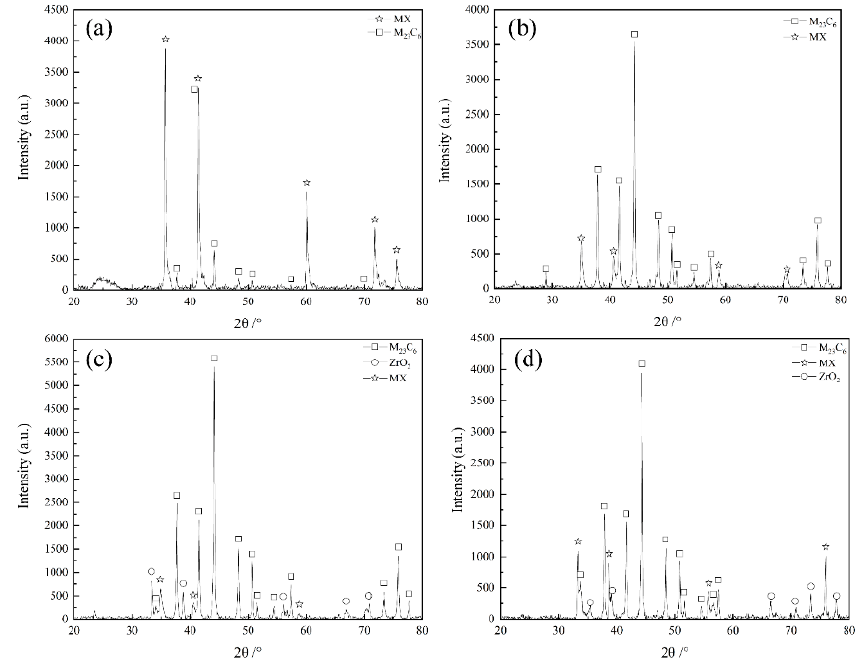
Figure 3. XRD results of precipitates in the steels. ( a ) 0ZrA, ( b ) 0.004ZrA, ( c ) 0.037ZrA, and ( d ) 0.098ZrA.